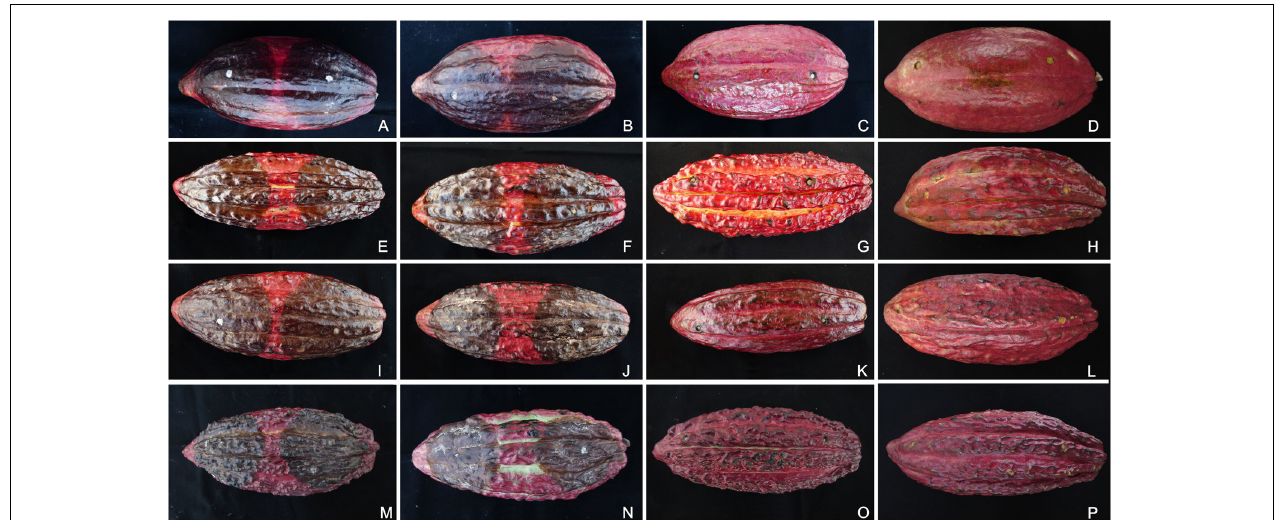
FIGURE 6 | Pathogenicity tests of Phytophthora species on artificially inoculated pods of different cacao genotypes. The inoculated pods were kept in a humidity chamber for 7 days at 20 ◦ C. The Phytophthora theobromicola (CCUB1091; A,E,I,M ), Phytophthora palmivora (CCUB1102; B,F,J,N ), Phytophthora citrophthora (P0479; C,G,K,O ), and mock treatments (D,H,L,P) are shown from left to right, respectively. The cacao clones PS1319 (A–D) , Cepec2004 (E–H) , CP49 (I–L) , and CCN51 (M–P) are shown from top to bottom, respectively.